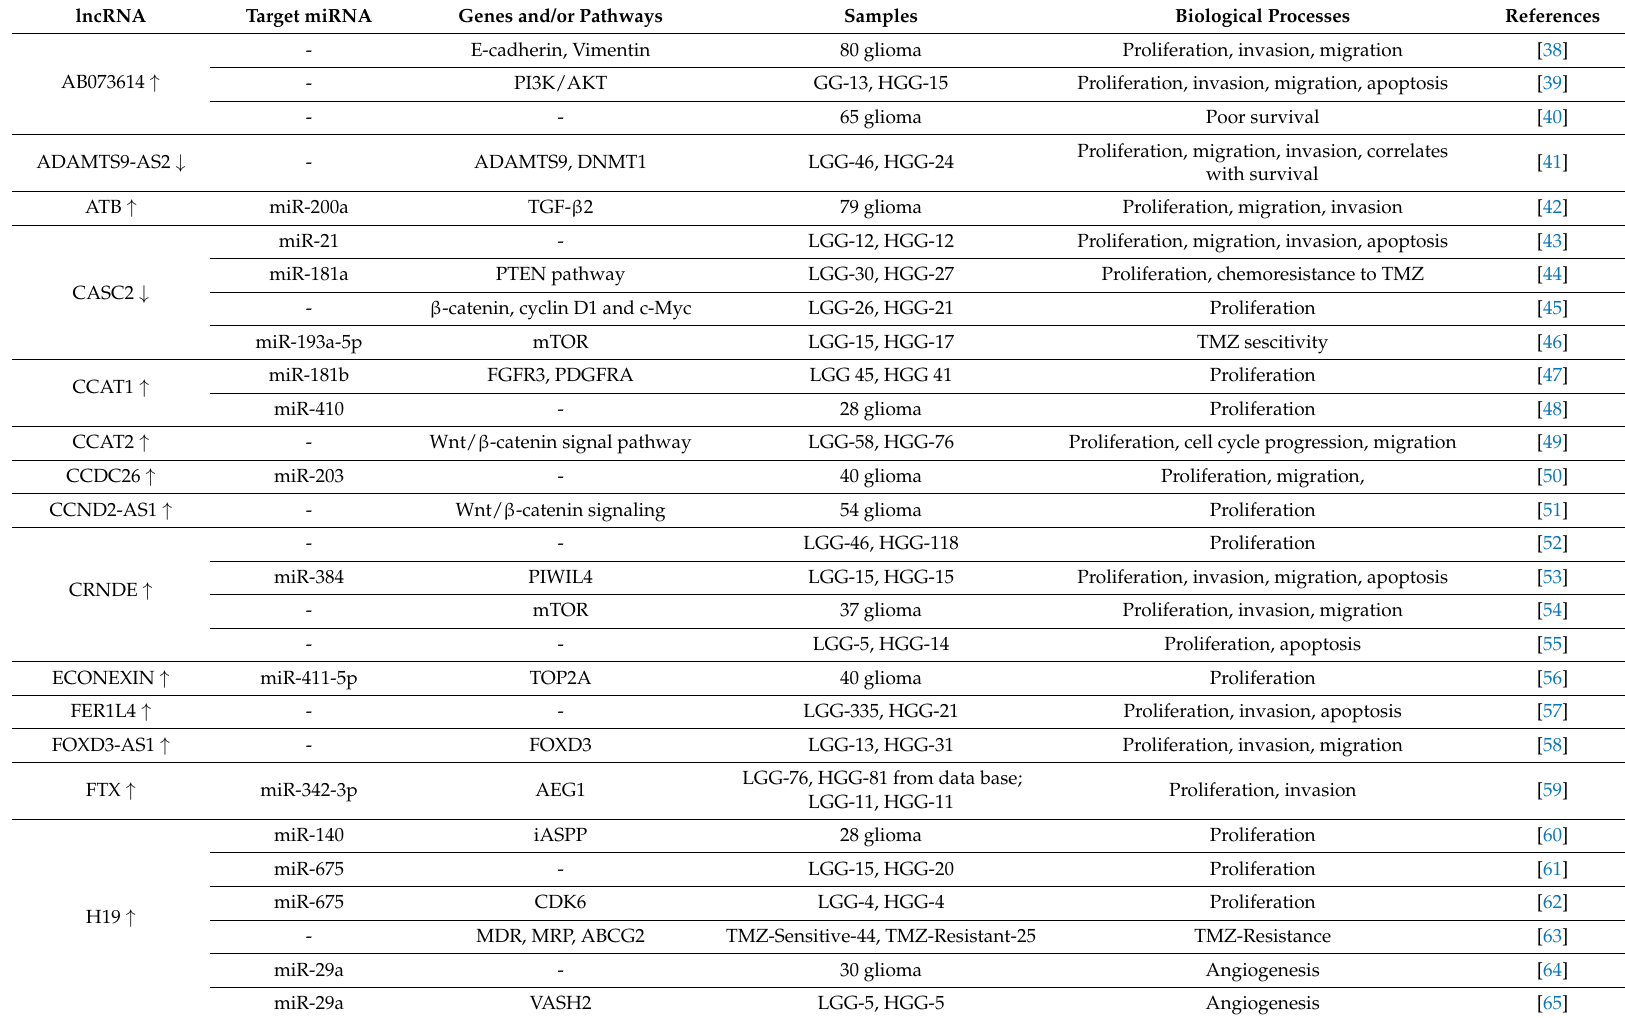
Table 1. Long non-coding RNAs altered in